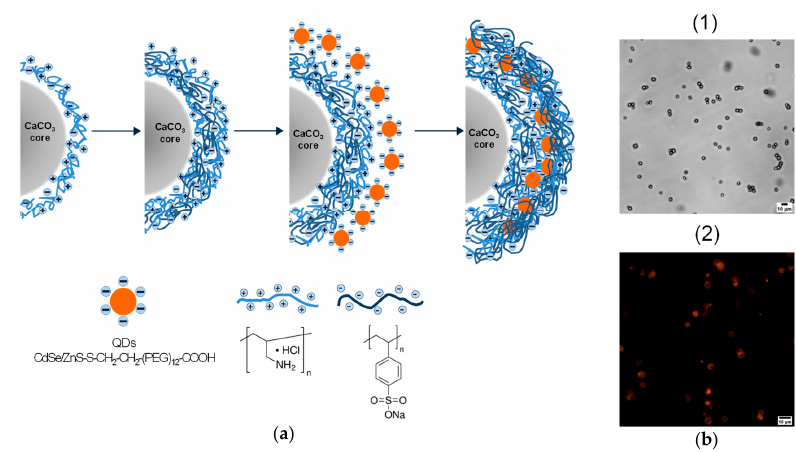
Figure 1. Polyelectrolyte shell formation and optical encoding with quantum dots (QDs) using a layer-by-layer deposition: ( a ) the scheme of the polyelectrolyte and QD deposition onto the calcium